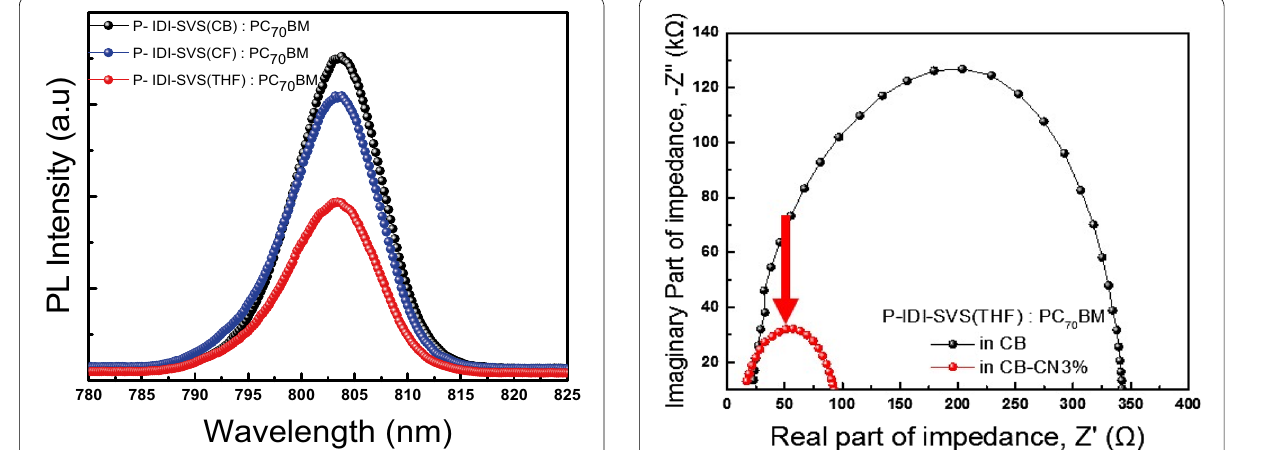
Fig. 4 PL intensities of different Soxhlet fraction P‑IDI‑SVS:PC 70 BM BHJ devices processed from solutions with CB added CN3%